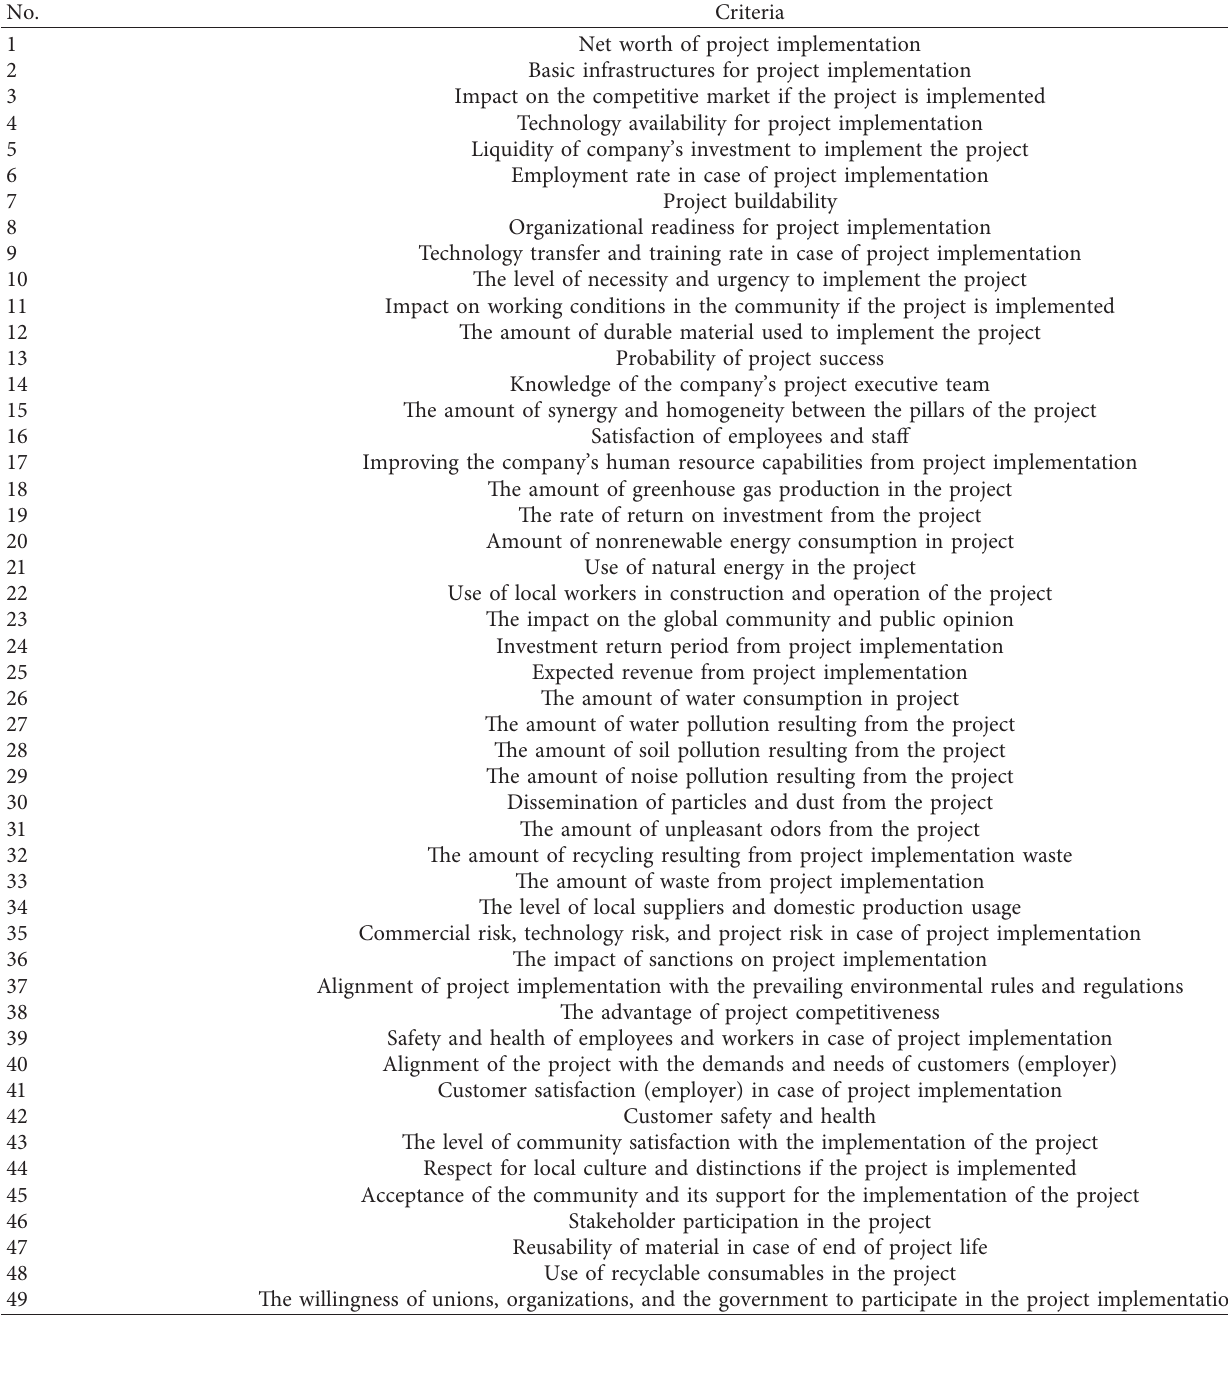
Table 4: Initial list of extracted criteria.